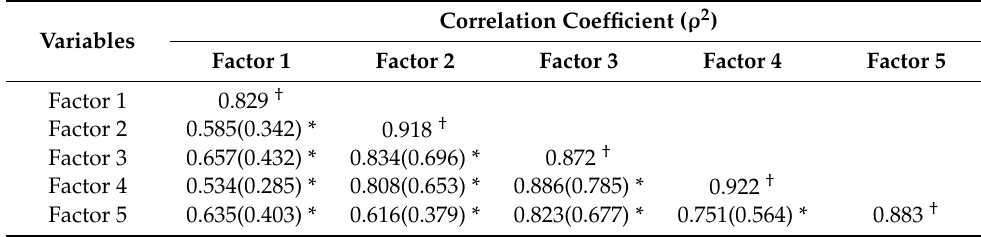
Table 5. Discriminant validity (AVE > ρ 2 ).